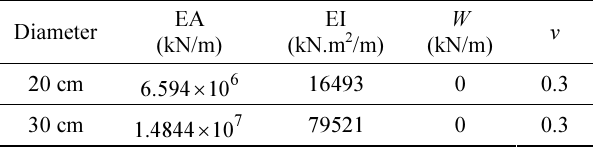
Table 8. Material parameters for bucket foundations